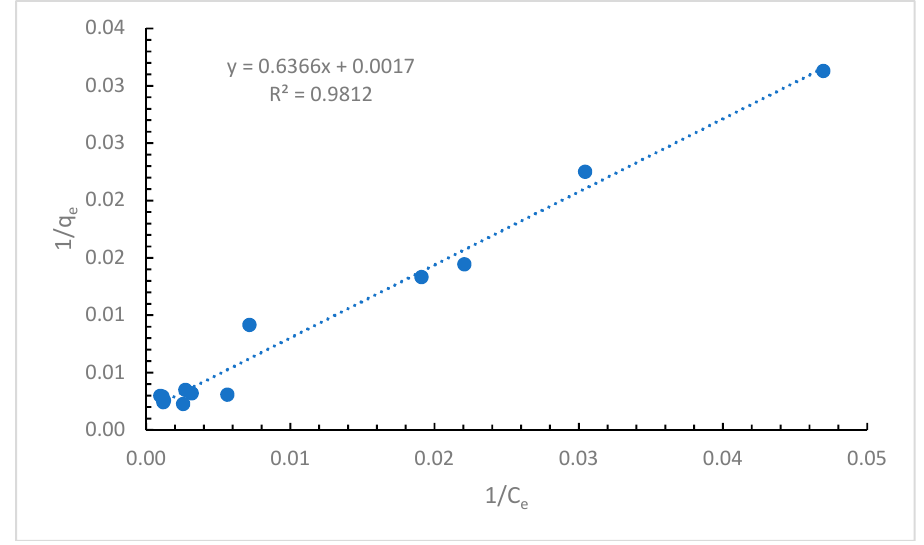
Figure 2. Langmuir adsorption isotherm.